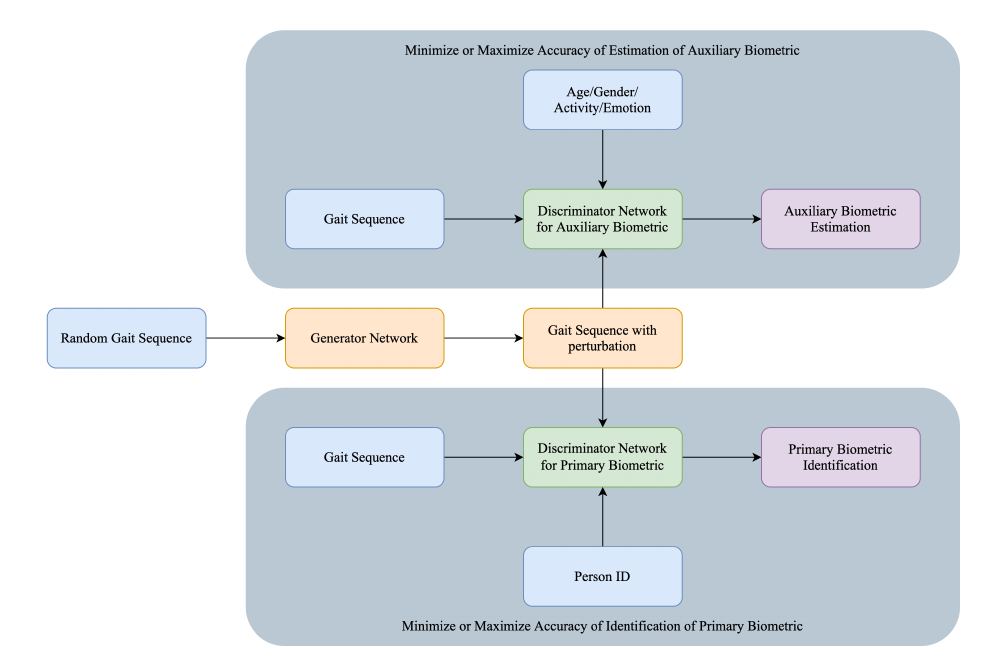
Figure 2. Architecture of gait-based biometric system that can identify both primary gait and auxiliary biometric